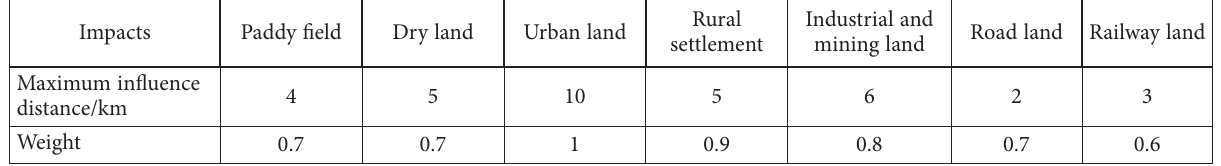
Table 1. Maximum influence distance and weight of threat factors Impacts